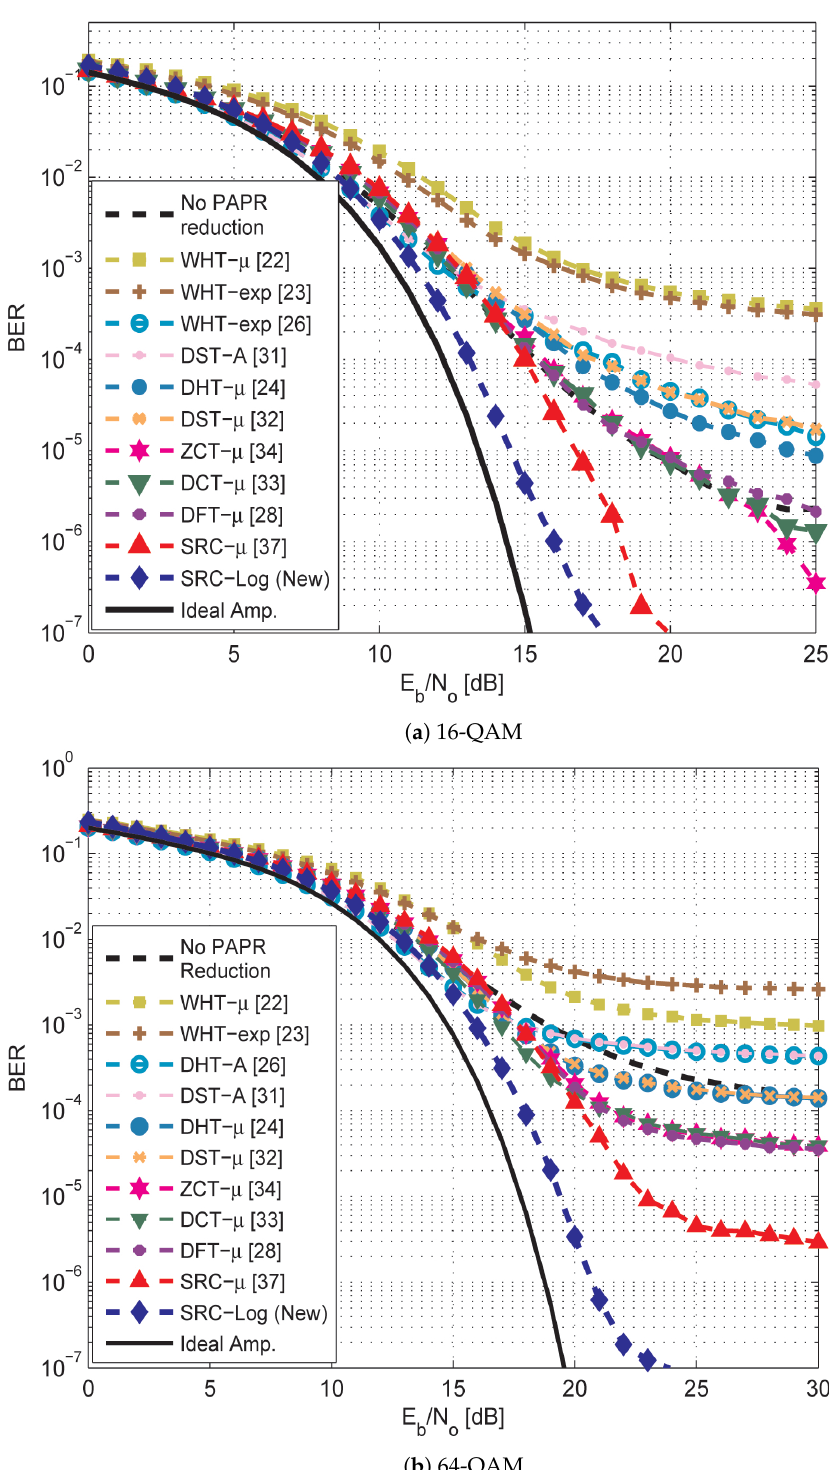
Figure 8. BER performance of the new SRC-Log compared with the previous precoding-companding techniques and OFDM without PAPR reduction in AWGN channel. In addition to the case of an ideal amplifier (solid